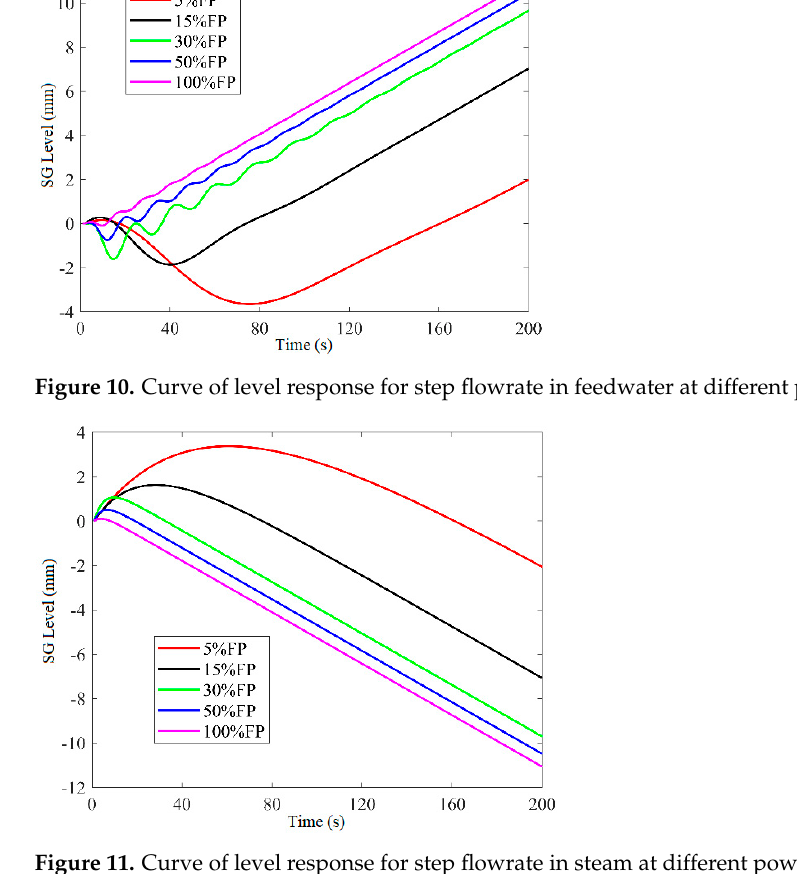
Figure 11. Curve of level response for step flowrate in steam at different powers.